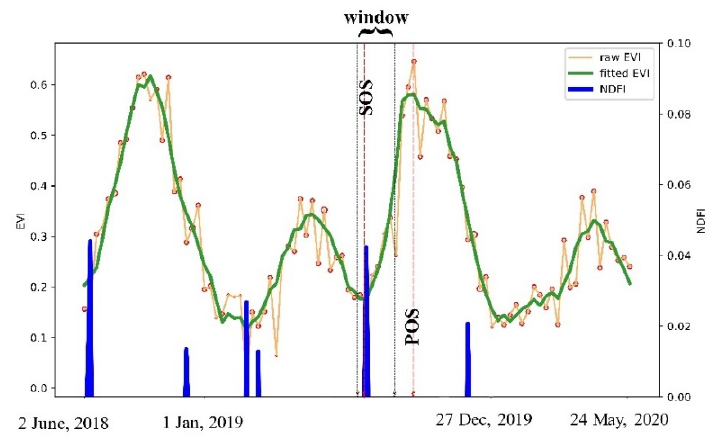
Figure 6. The NDFI, raw and fitted EVI are in blue, orange, and green, respectively. The size of the red cycle (big/medium/small) denotes the quality of the associated observation